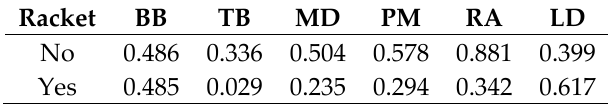
Table 8. P -value of mean amplitude for One Stroke (back